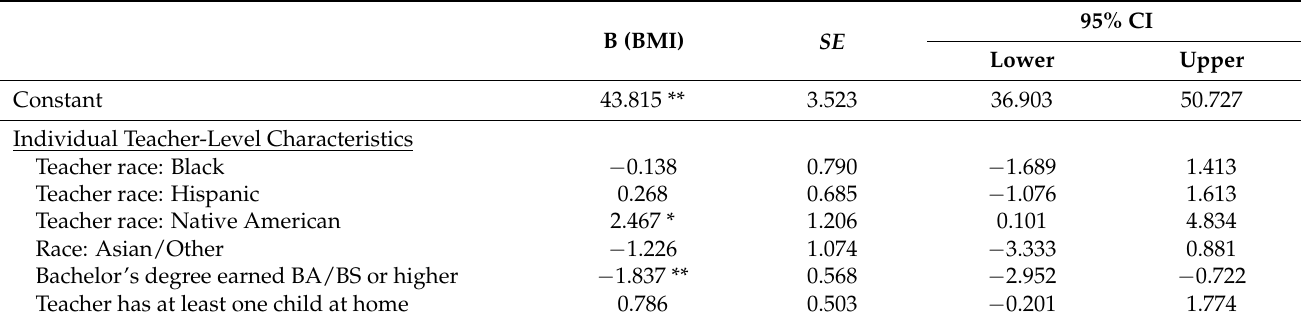
Table 4. Ordinary Least Squares Regression Results Predicting Body Mass Index (BMI) in